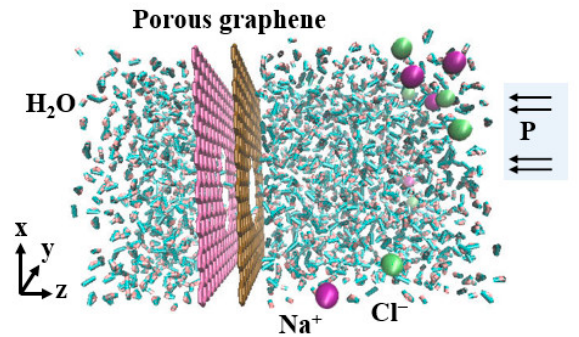
Figure 1. Reverse osmosis model for a salt solution driven by external pressure P. The blue balls are sodium ions, the purple balls are chloride ions, the pink and yellow-brown areas represent the porous graphene membrane and the others features are water molecules.